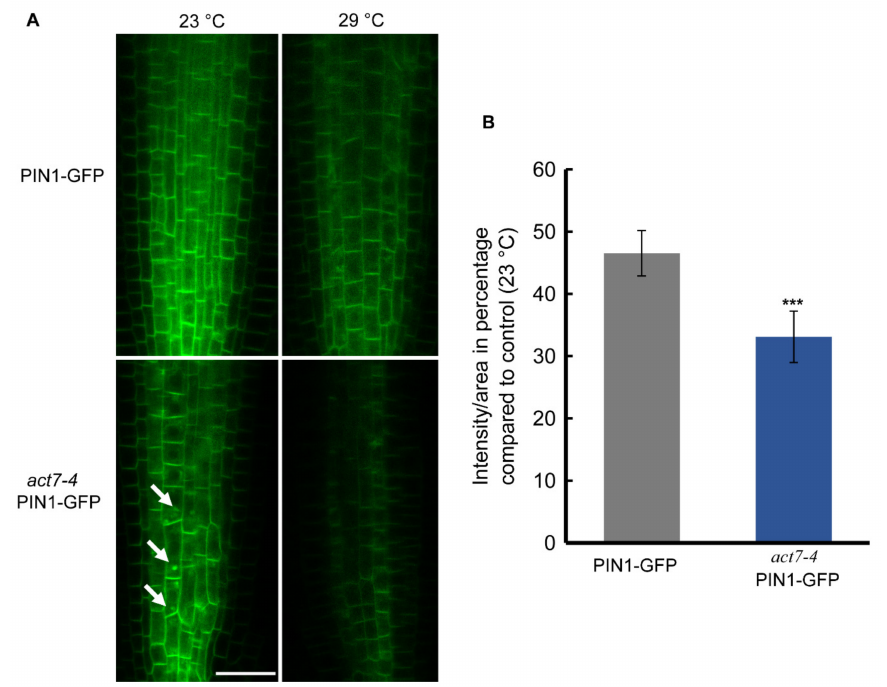
Figure 3. Prolonged moderate-high temperature affects PIN1 abundance in roots of Col-0 and act7-4 mutants. ( A ) PIN1 -GFP and act7-4 PIN1-GFP at 23 and 29 ◦ C. Bar = 25 µ m. Arrowheads indicate